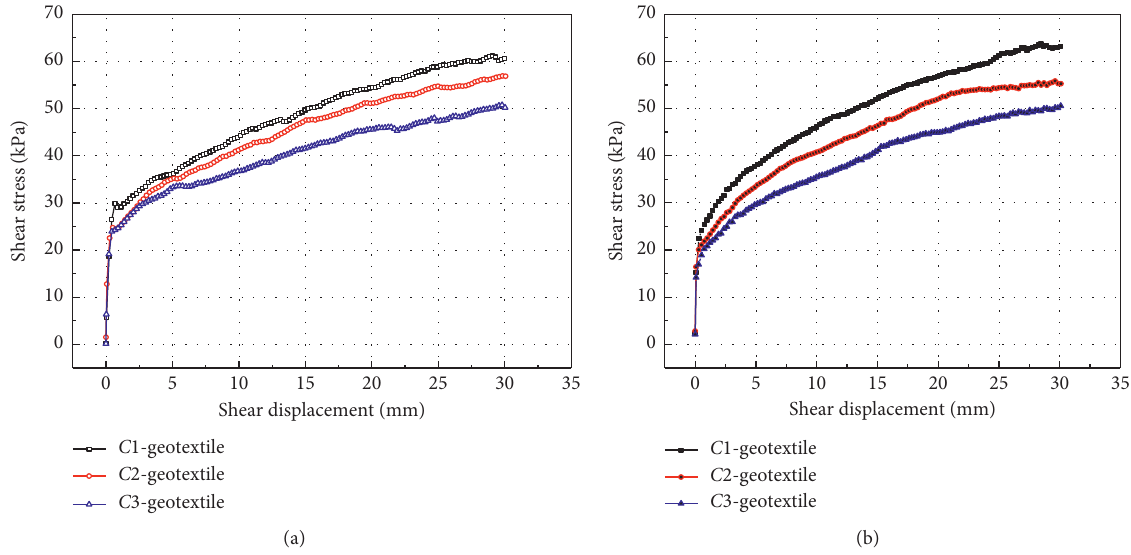
Figure 6: Effect of sand particle size on the interface shear stress-shear displacement curves in the (a) MDS and (b) PCDS tests.